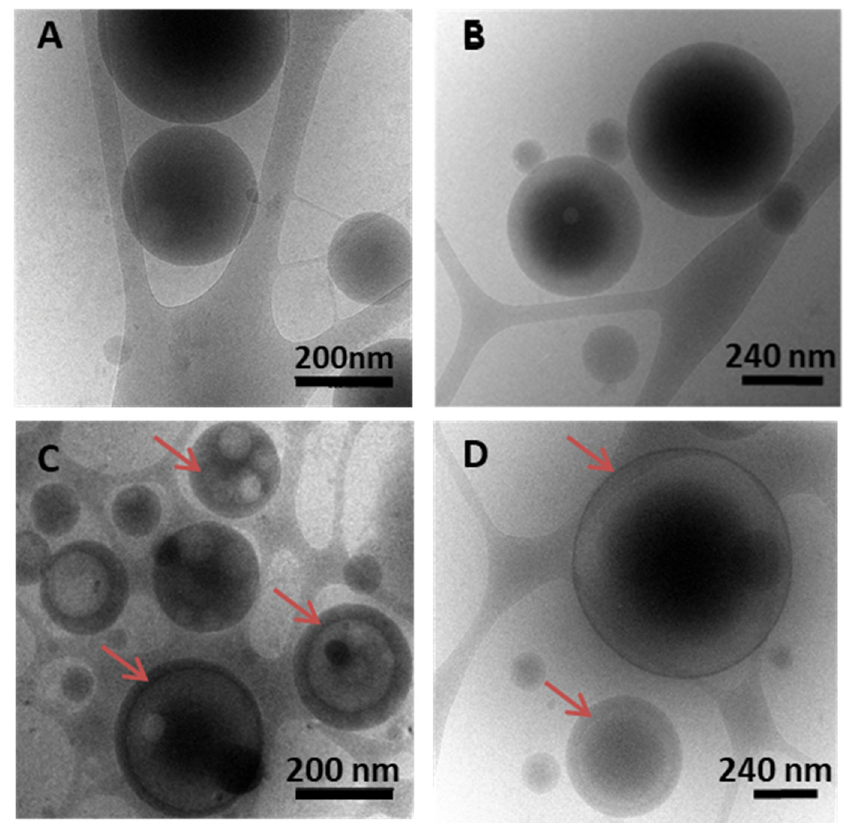
Figure 6. Representative cryo-TEM images of ( A ) empty PLGA 15 C NPs; ( B ) empty PLA 8 C NPs; ( C ) VCM-loaded PLGA 15 C NPs; and ( D ) VCM-loaded PLA 8 C NPs. Polymer shells are indicated with red arrows.